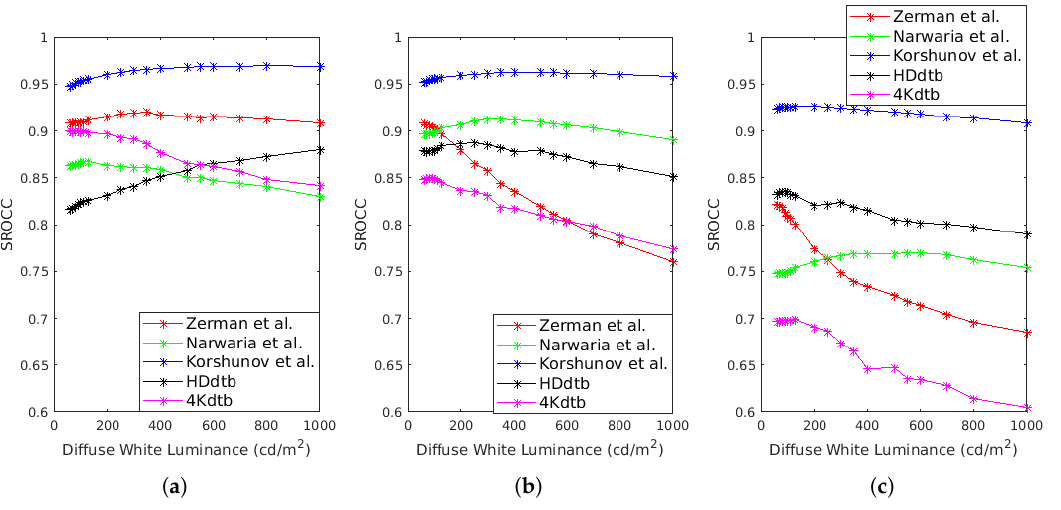
Figure 13. SROCC of ( a ) FSIM HDR - Lab , ( b ) MS-SSIM HDR - Lab , ( c ) SSIM HDR - Lab in function of the diffuse white